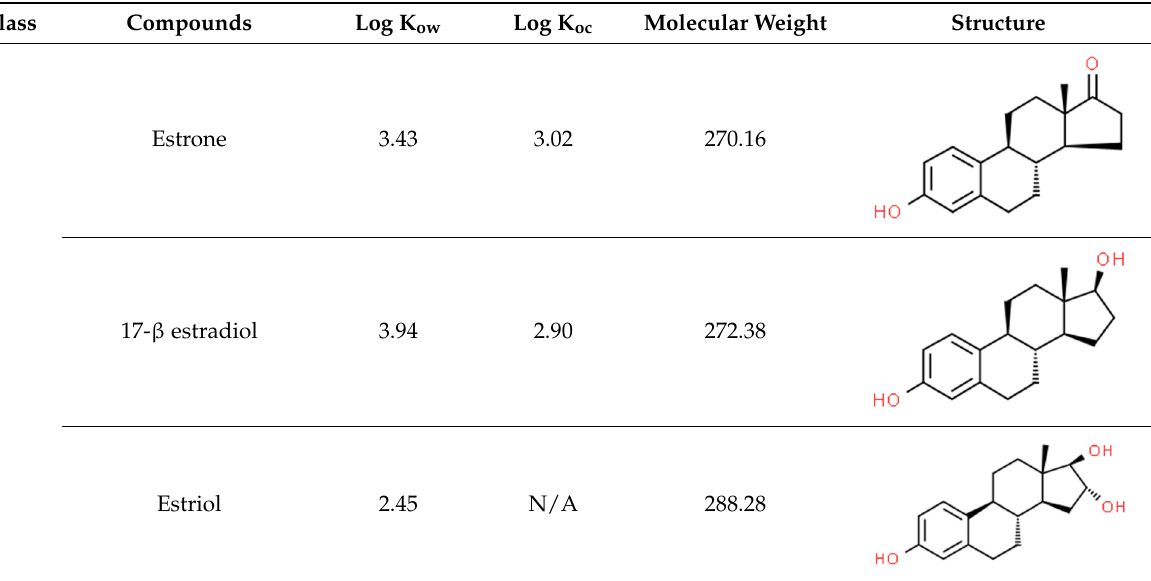
Table 1. Physiochemical properties of targeted steroid and hormones.